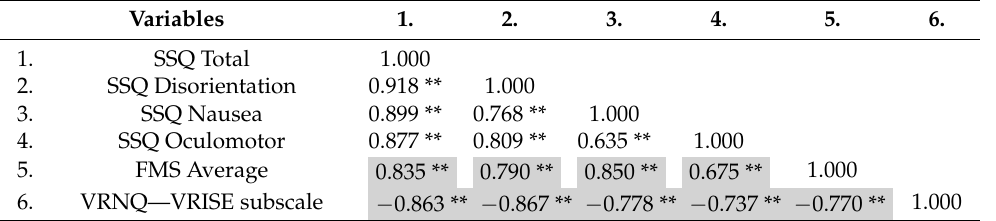
Table 8. Correlation matrix for HA_RFG condition—Spearman ( ρ ) correlation coefficients for com- bined VRISE measures ( n = 6).